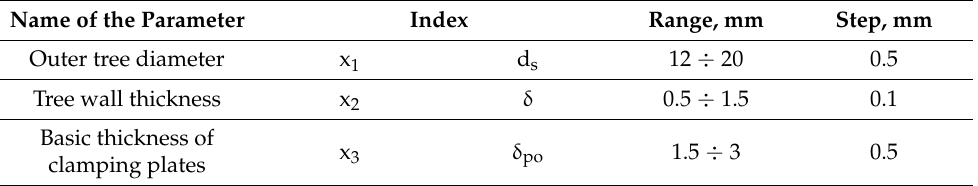
Table 6. Optimization parameters (referent design parameters) of external fixation